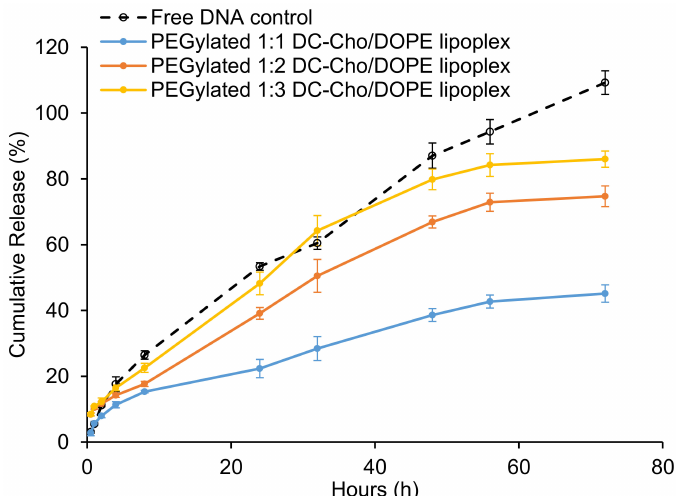
Figure 3. In vitro DNA release profile of free DNA (control). PEGylated 1:1, 1:2 and 1:3 DC- chol/DOPE lipoplexes over a 72 h period. Data represented as mean ± SD ( n = 3).